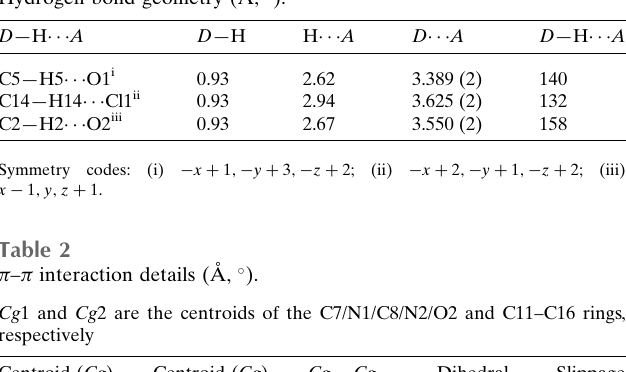
Table 1 Hydrogen-bond geometry (A˚ , (cid:3) ).